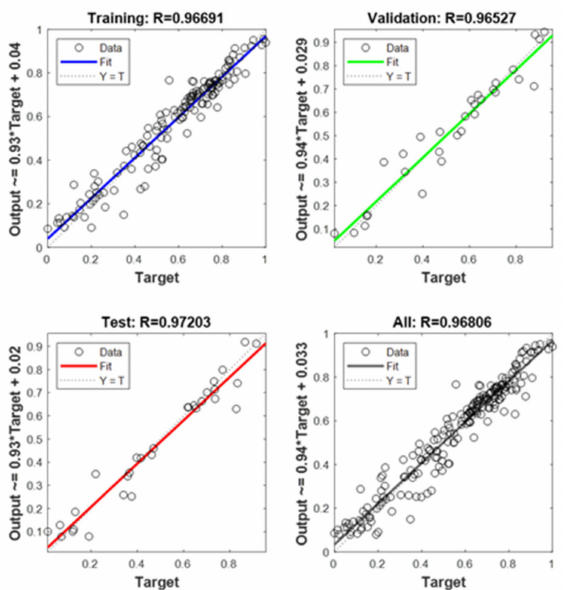
Figure 2. The ANN structure.